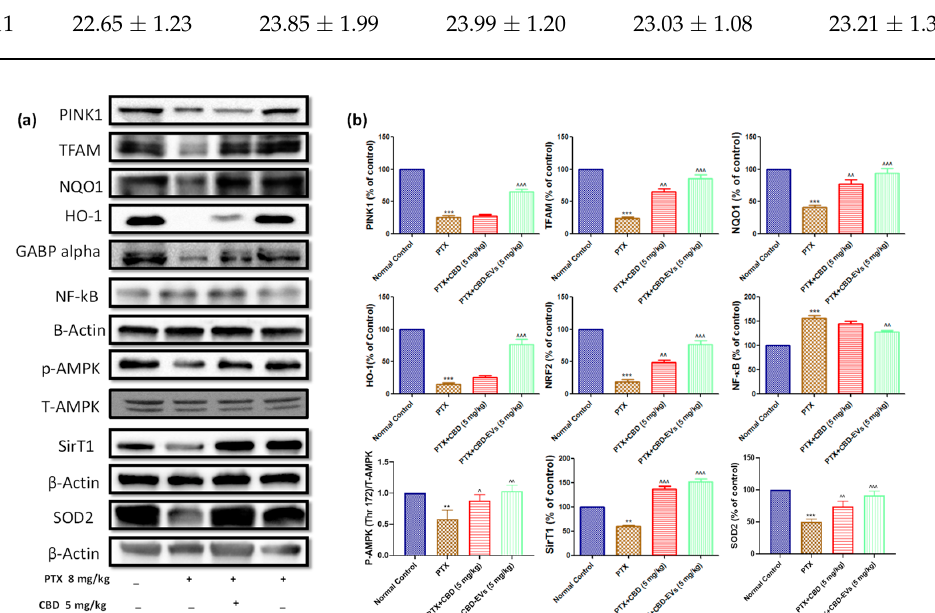
Figure 5. Effect of CBD and CBD-EVs on AMPK-SIRT1-NRF1/2 Axis. ( a ) Western blots of DRG homogenates from PTX-treated mice show treatment with CBD (5 mg/kg) and CBD-EVs (5 mg/kg) for six weeks after last dose of PTX administration. ( b ) Bar graphs represent the respective western blots quantification. Values are expressed as mean ± SEM (n = 3). ** p < 0.01 and *** p < 0.001 vs. Normal control, ^ p < 0.05, ^^ p < 0.01 and ^^^ p < 0.001 vs. PTX (8 mg/kg). NC: untreated age- matched mice, PTX: mice received (8 mg/kg/day) on alternate days for four injections cumulatively, PTX + CBD (5 mg/kg): 5 mg/kg CBD (i.p.) injected twice a week for six weeks after the last PTX injection, PTX + CBD − EVs: 5 mg/kg of CBD loaded in hUCMSCs-derived EVs (i.p.) injected twice a week for six weeks after the last dose of PTX injection. Additionally, in PTX-treated mice, spinal homogenates showed significantly lower protein expressions of SOD2 ( p < 0.001), Parkin ( p < 0.001), SIRT1 ( p < 0.001), SIRT3 ( p < 0.05), and catalase ( p < 0.05). CBD and CBD-EVs treatment significantly increased the ex-